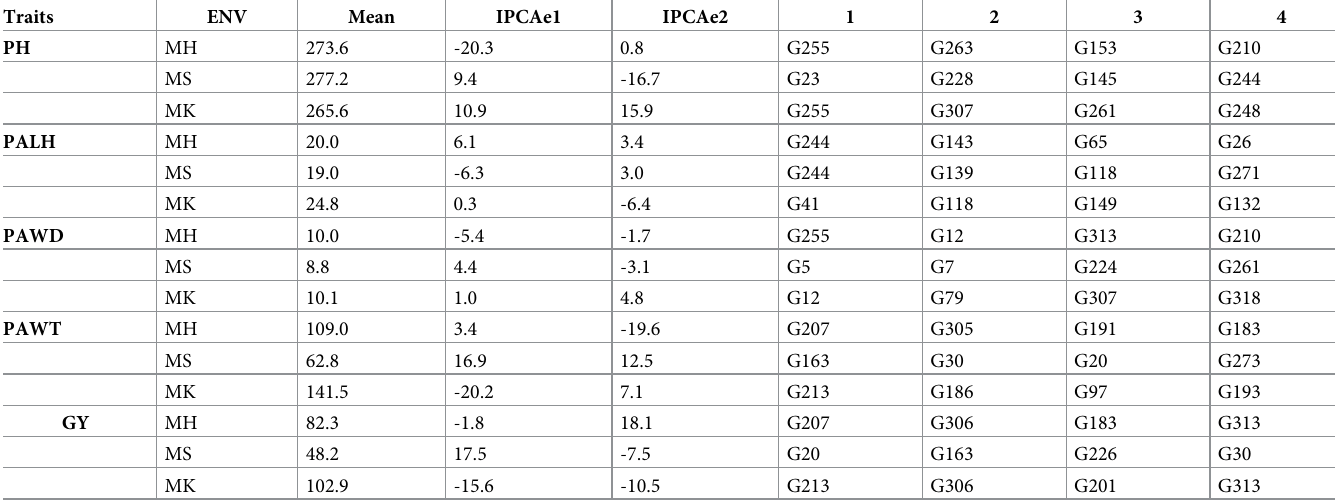
ENV = Environment; IPCAe1 and IPCAe2 = The first and the second interaction principal component axis score of environments; PH = Plant height, PALH = Panicle length, PAWD = Panicle width, PAWT: Panicle weight, GY: Grain yield; MH = Mehoni; MS = Mieso; MK =